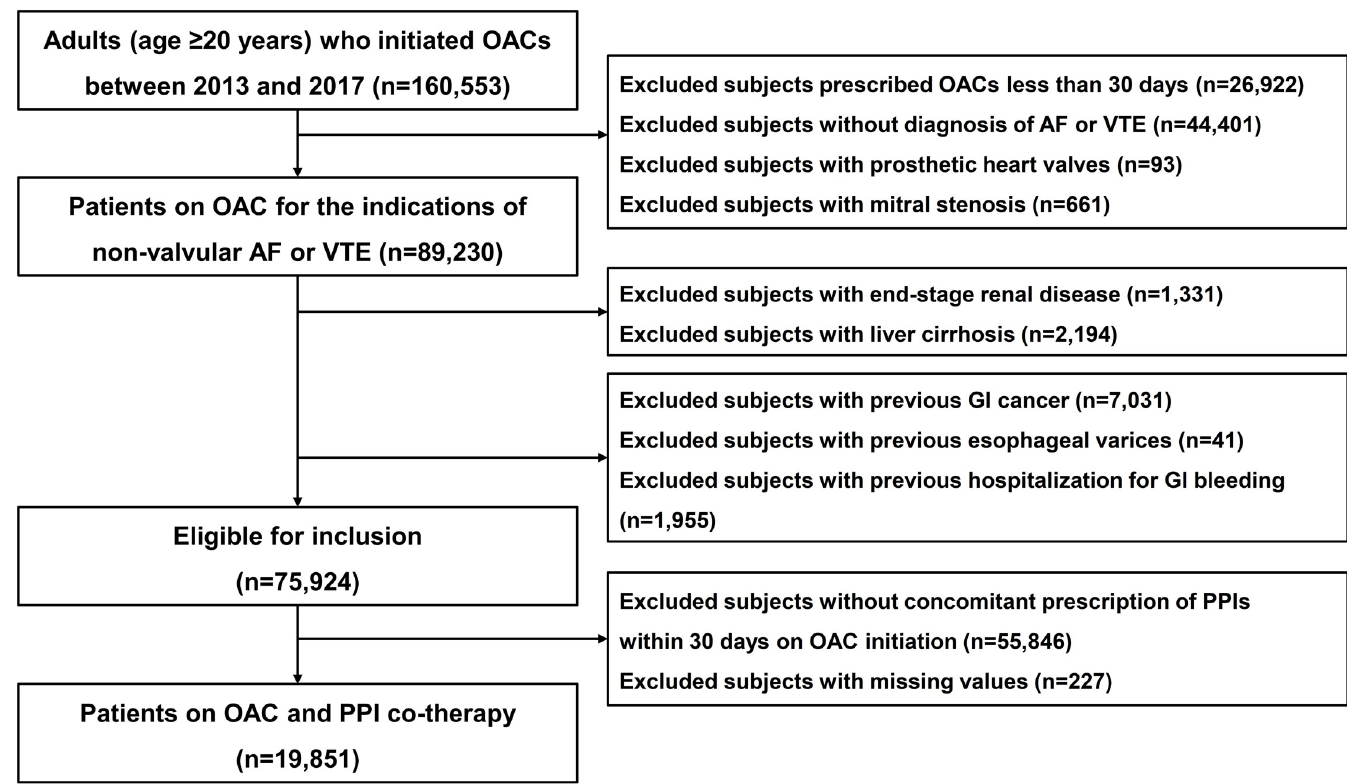
Fig 1. Study inclusion flow. OAC, oral anticoagulant; AF, atrial fibrillation; VTE, venous thromboembolism; GI, gastrointestinal; PPI, proton pump inhibitor.